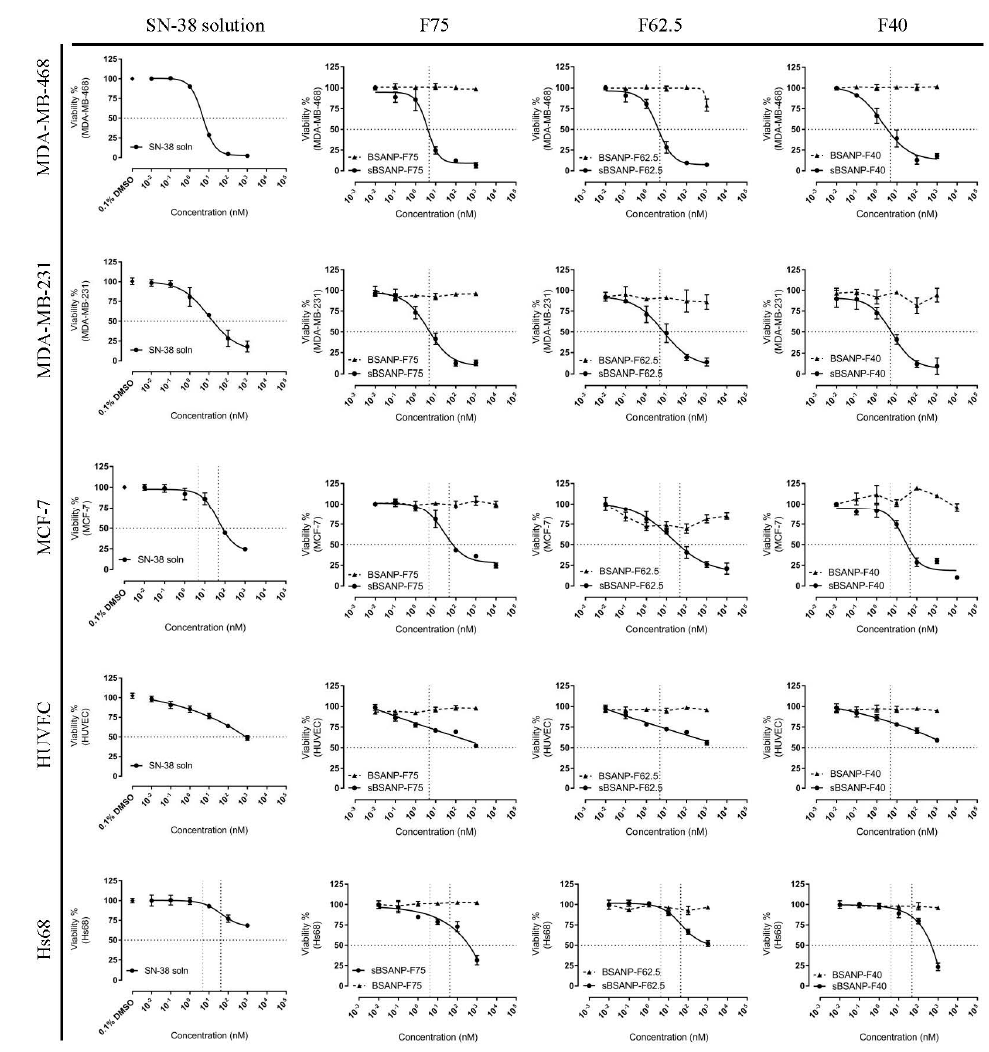
Figure 6. Dose-dependent effect of SN-38-containing control solution, BSANPs, and sBSANPs (F75, F62.5, F40) on different cell lines’ cell viability including MDA-MB-468, MDA-MB-231, MCF-7, HUVEC, and HS 68 cell lines. Note: MDA-MB-468 and MDA-MB-231 (ER − , PR − , HER2), MCF-7(ER+, PR+, HER2 − ), HUVEC(human umbilical vein endothelial cell), Hs68 (health human fibroblast cell). Table 2. IC 50 values of SN-38-loaded BSANP at 75, 62.5, and 40 mg/mL BSA concentrations in